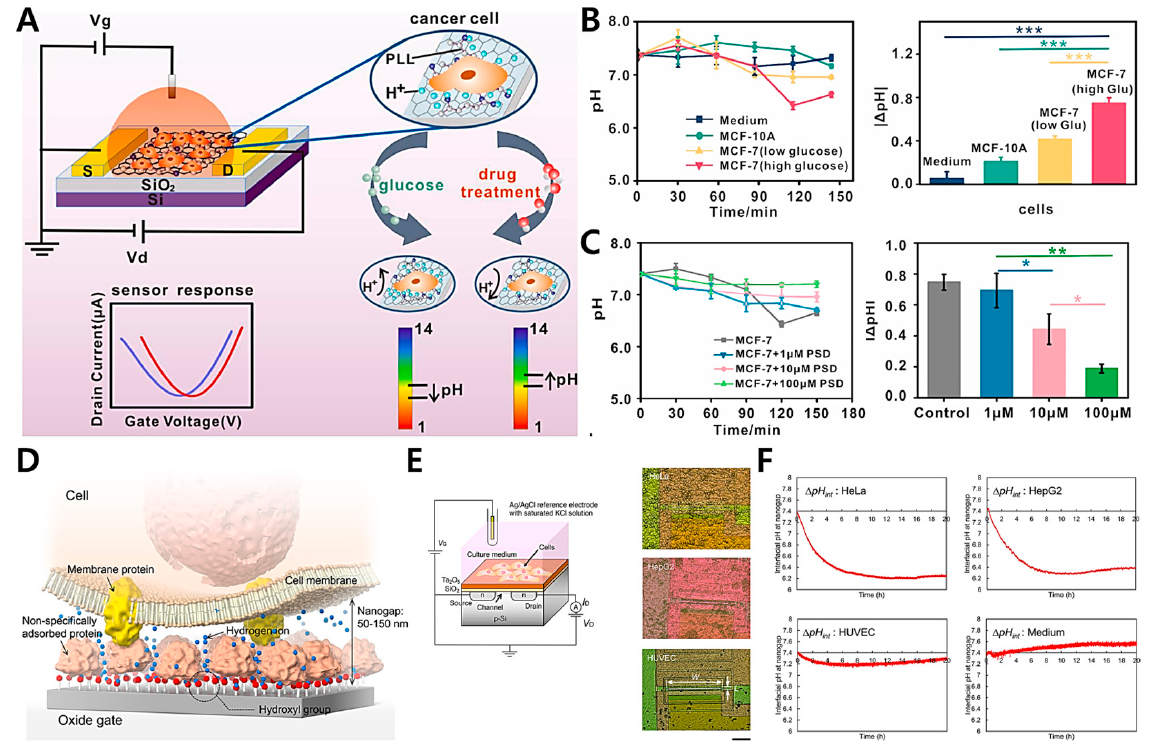
Figure 3. ( A ) A PLL@G-FET electrochemical biosensor that measures extracellular pH. ( B ) Monitoring of cancer cell metabolism. Comparing the extracellular acidification and pH of MCF-10A cells with those of MCF-7 cells. ( C ) Identification of the extracellular acidification of MCF-7 cells without drug treatment and with different drug concentrations (left panel), and pH changes with the intervention of various drug concentrations within 150 min (right panel). ( D ) A diagrammatic representation of the cell/gate nanogap interface. ( E ) Cell-coupled gate ISFET (left panel); HeLa, HepG2, and HUVEC cells were grown on the Ta 2 O 5 gate (right panel). ( F ) Changes in interfacial pH at the cell/gate nanogap are measured for each cell by using a cell-coupled gate ISFET biosensor. Reprinted with permission from [74]. Copyright 2022, Elsevier. Reprinted with permission from [73]. Copyright 2018, Royal Society of Chemistry.